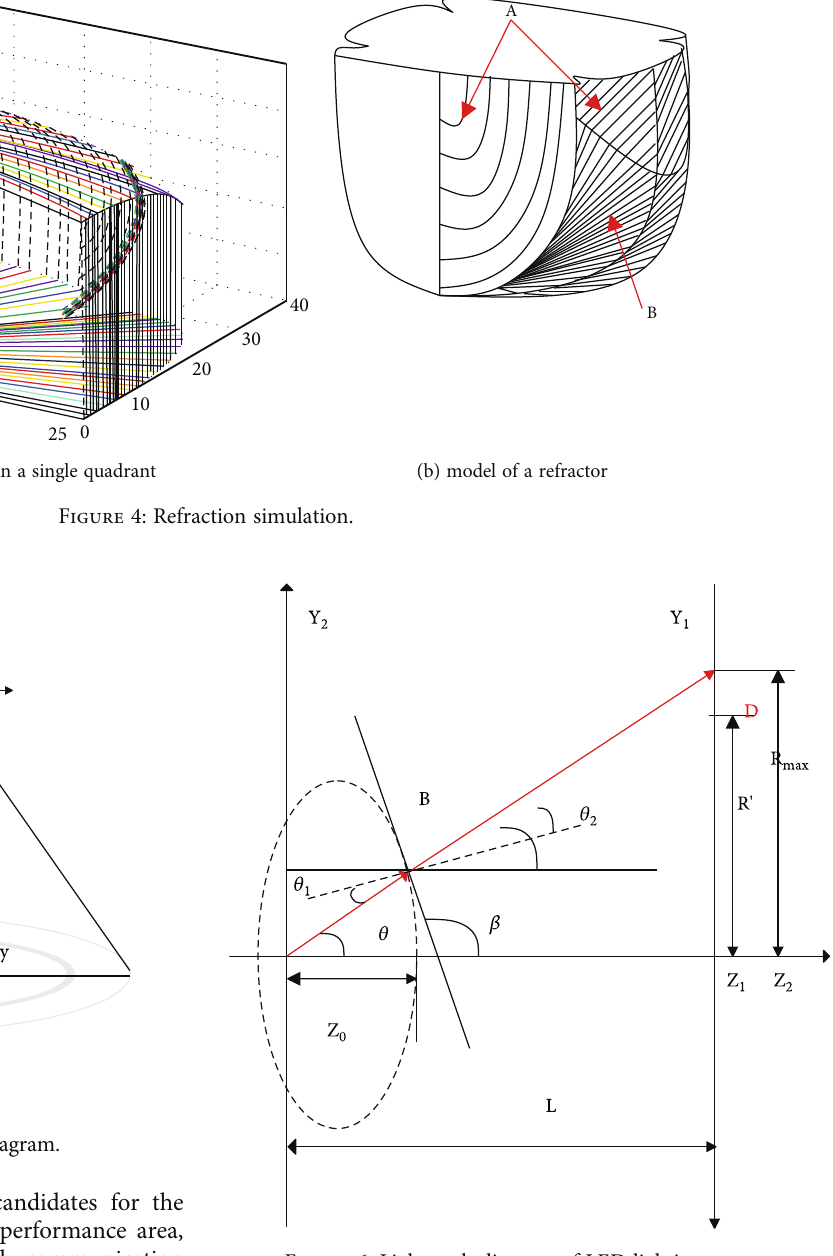
Figure 6: Light path diagram of LED lighting